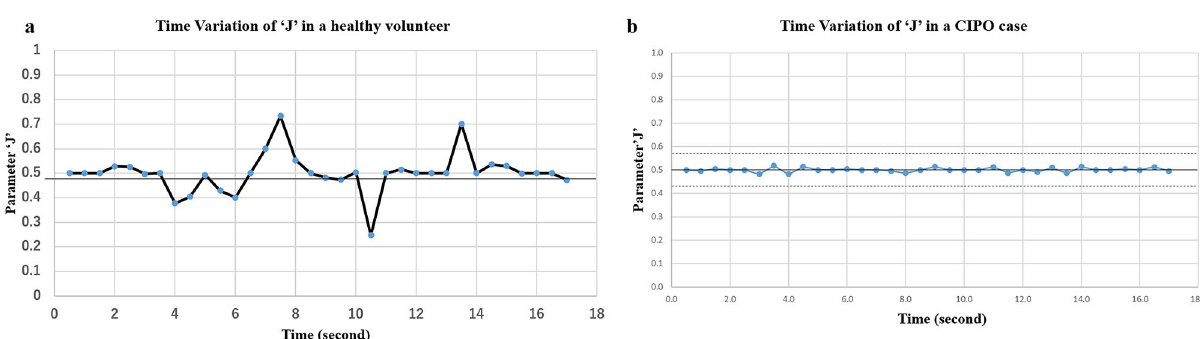
Figure 5. Time variation of parameter J in a healthy volunteer ( a ) and a case of chronic intestinal pseudo- obstruction ( b